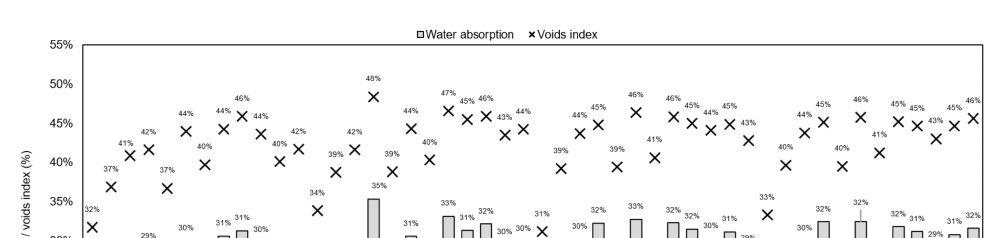
Figure A4. Water retention.